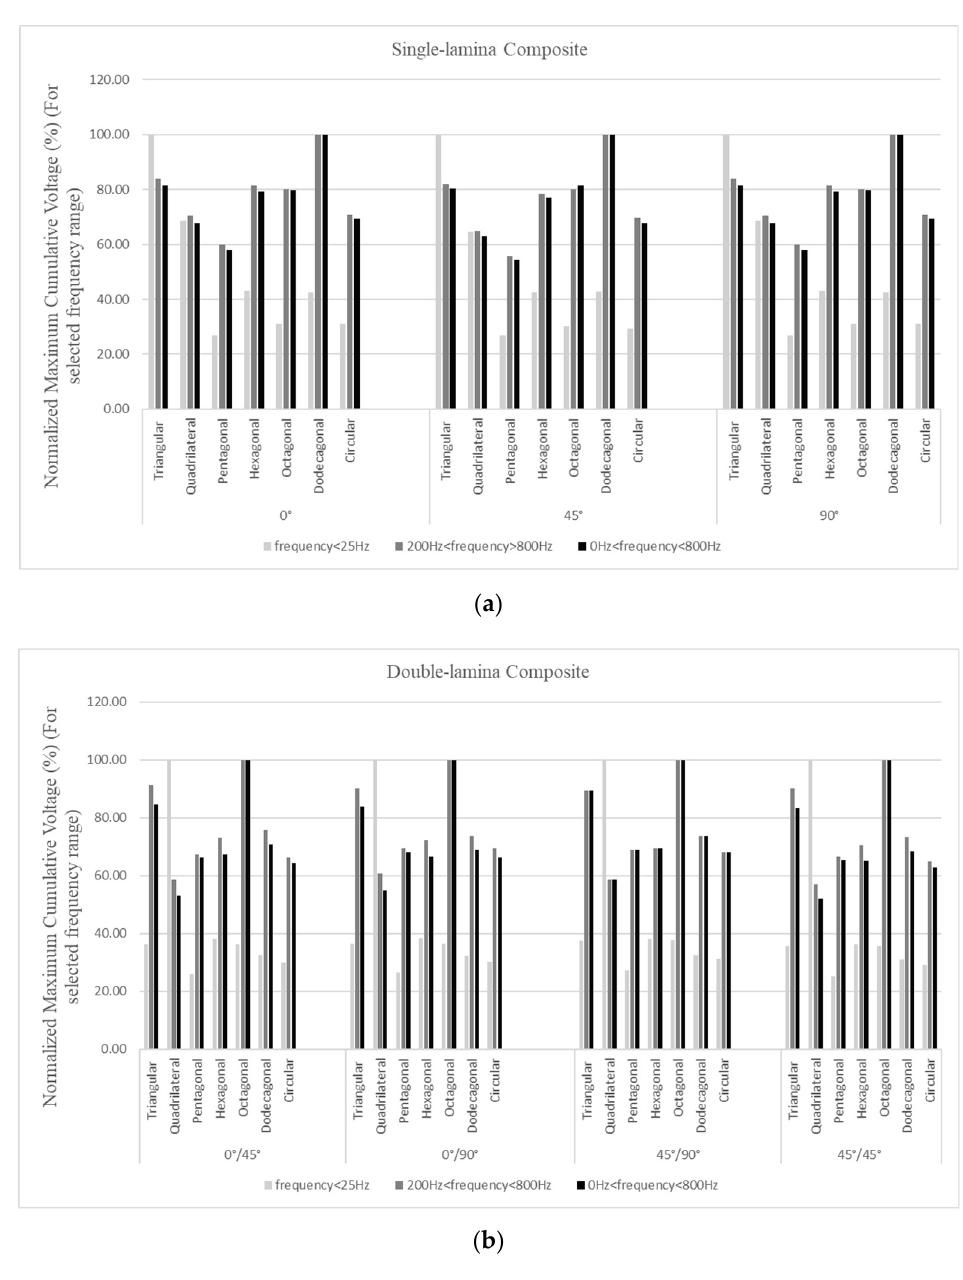
Figure 14. Normalized maximum cumulative voltage ( a ) single-lamina and ( b ) double-lamina composites.